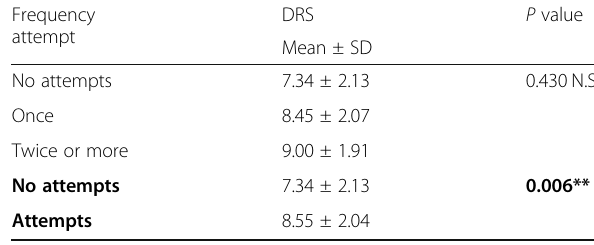
Table 4 Relationship between frequency of previous suicidal attempts and disability in the studied